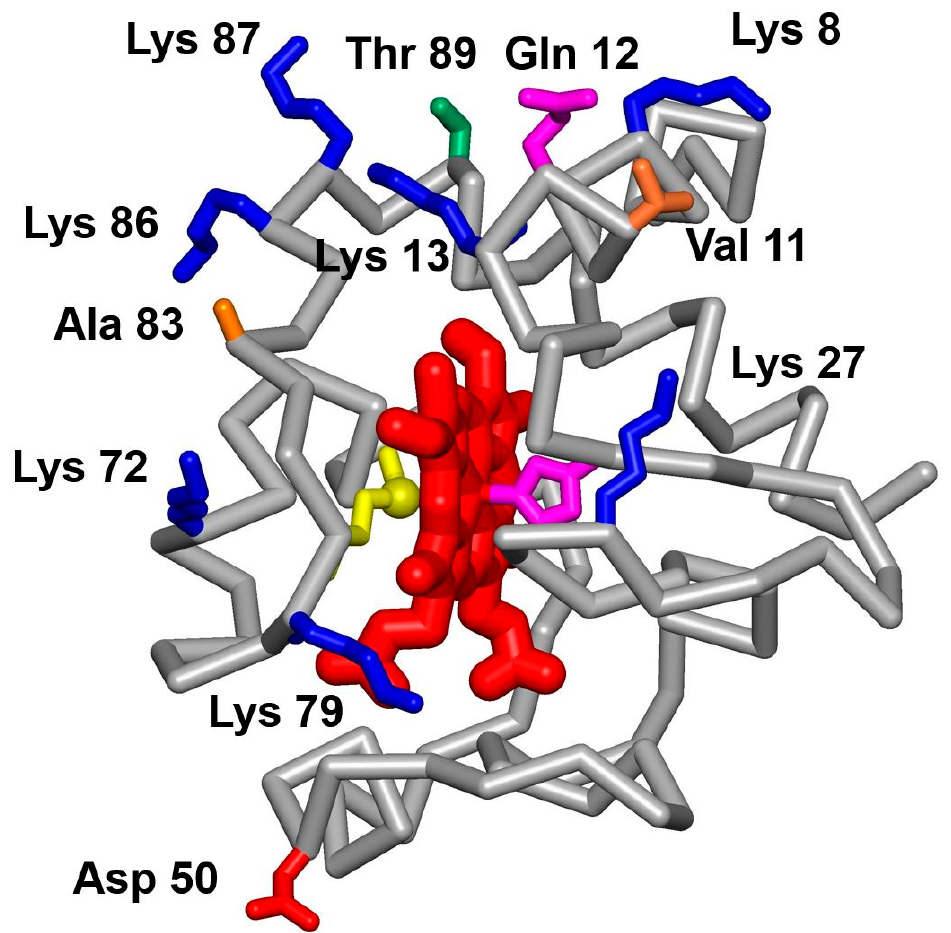
Figure 1. Horse Cc crystal structure (PDB 1HRC) with the heme shown in red, the histidine 18 and methionine 80 iron ligands shown in purple and yellow, and the lysines involved in binding electron transfer partners shown in blue. The amino acids Val 11, Gln 12, Asp 50, Ala 83, and Thr 89 that are mutated in human Cc are also shown.